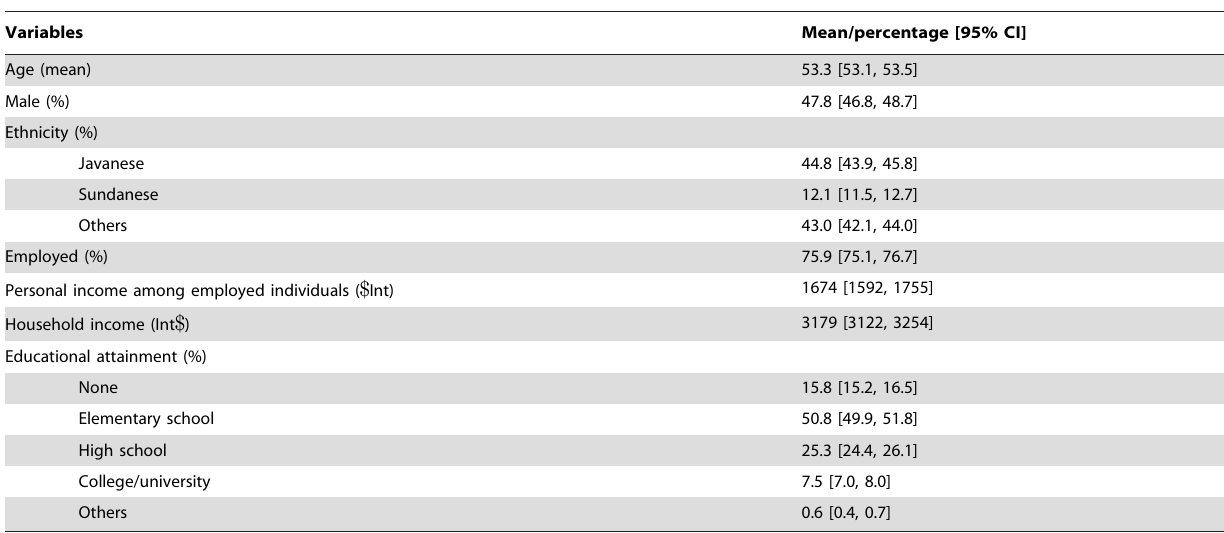
Table 1. Sample demographics (n=